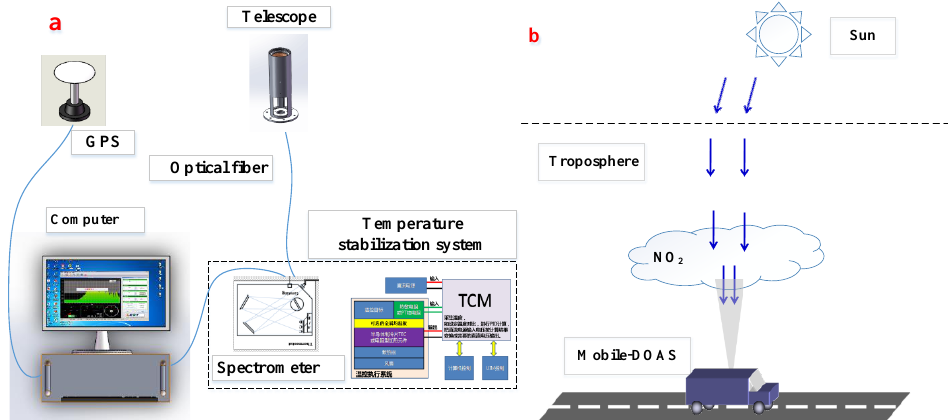
Figure 3. ( a ) The mobile zenith-sky di ff erential optical absorption spectroscopy (DOAS) system; ( b ) the Figure 3. (a) The mobile zenith-sky differential optical absorption spectroscopy (DOAS) system; (b) measurement principle of the mobile-DOAS system. the measurement principle of the mobile-DOAS system.